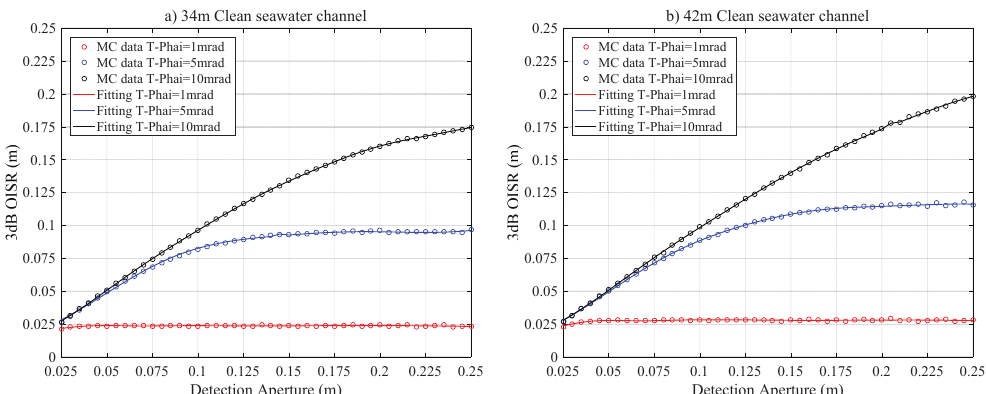
Figure 6. The r 3 dB versus R PD for the clean seawater laser channel for a link distance of ( a ) 34 m and ( b ) 42 m.